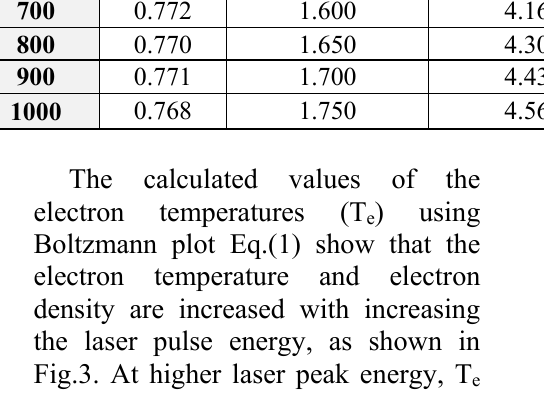
Fig. 3: The variation of (T